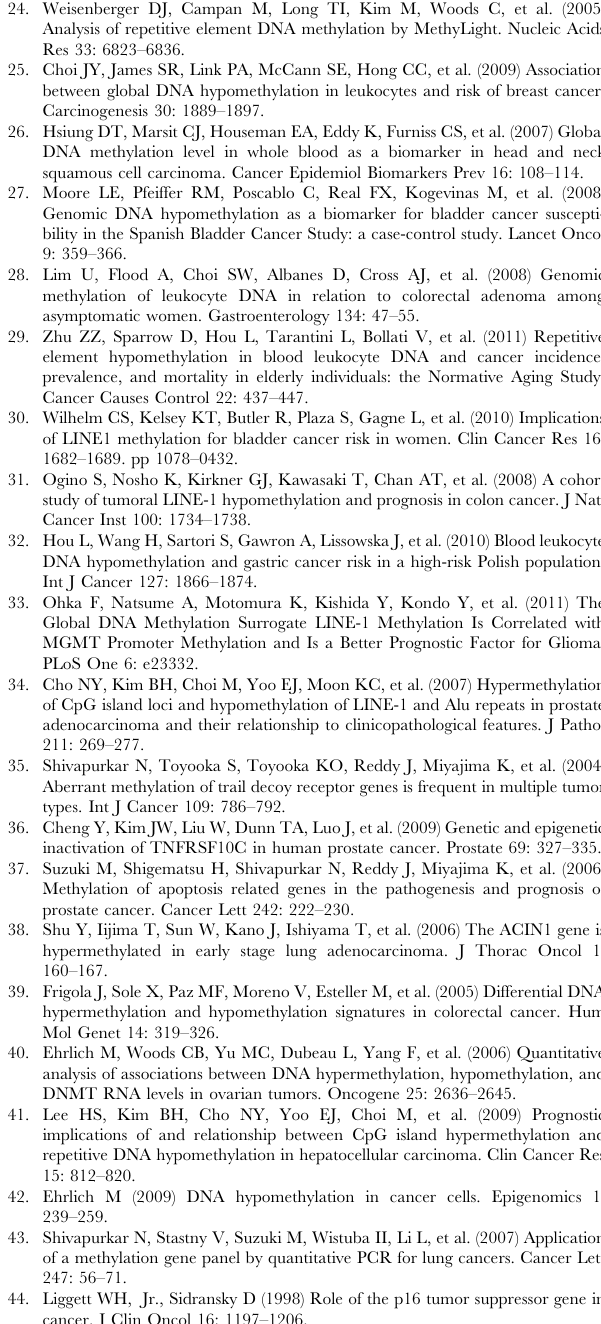
Figure S2 HPLC chromatograms samples of investigat- ed CpGs. First peak indicates primer, second peak, ddCTP and third peak, ddTTP extended oligos. Peak height is automatically calculated by WAVEMAKERTM software (Transgenomic). Table S1 Specific primers used for methylation-specific polymerase chain reaction (Bi) and SIRPH (SN) analysis. (PDF) Table S2 Raw data of methylation percentage of pancreatic ductal adenocarcinoma patients (blood: